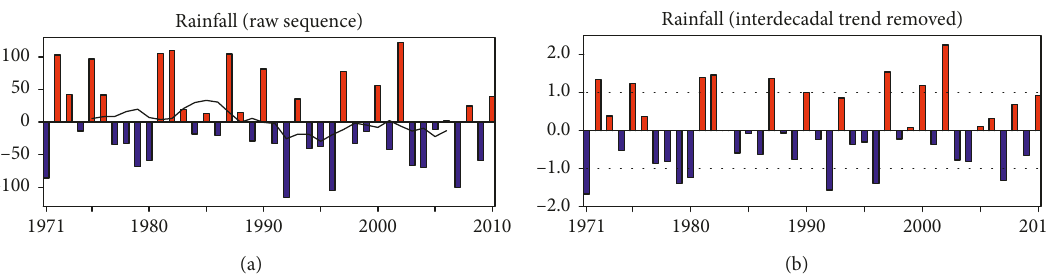
Figure 2: (a) SEC area average autumn rainfall anomaly during 1971–2010 (unit: mm per season, the black curve denotes the 9-year running average). (b) Standardized sequence of the interannual variation (from 1971–1990 minus mean and 1991–2010 minus mean) of SEC rainfall for 1971–2010, and black lines represent one standard